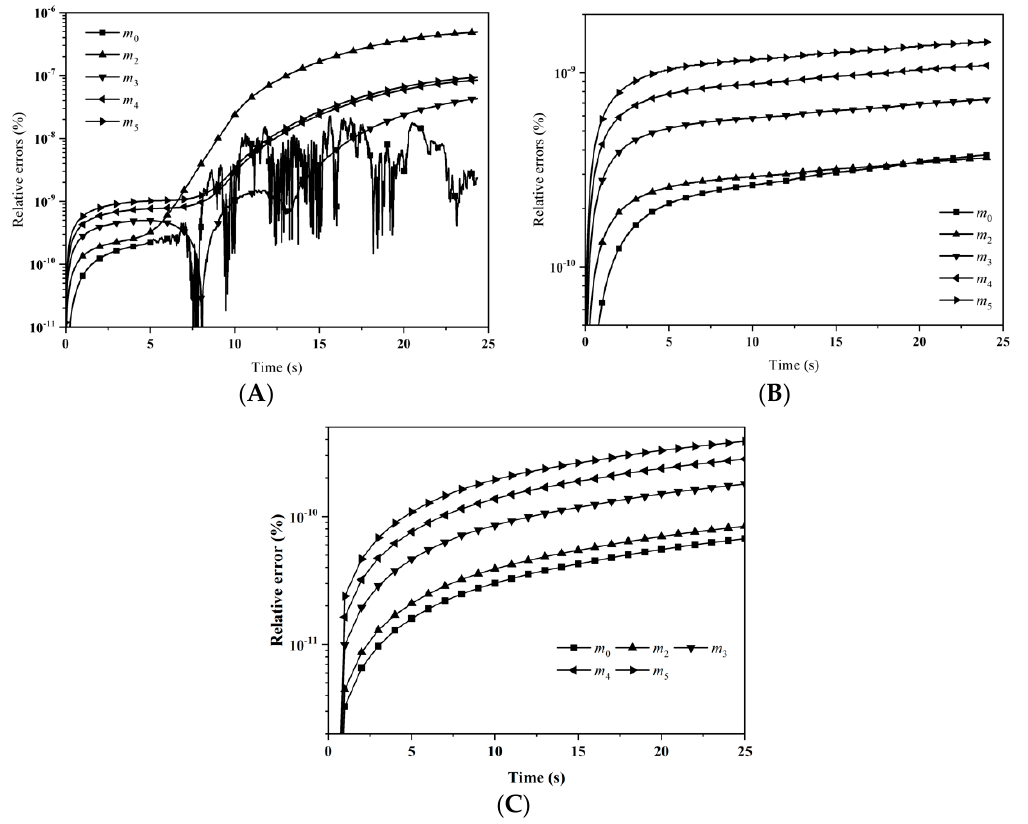
Figure 5. Evolution of relative errors for the first six moments with: ( A ) LFPQMOM; ( B ) QMOM; and ( C ) FPQMOM (square: m 0 ; up triangle: m 2 ; down triangle: m 3 ; left triangle: m 4 ; right triangle: m 5 ).